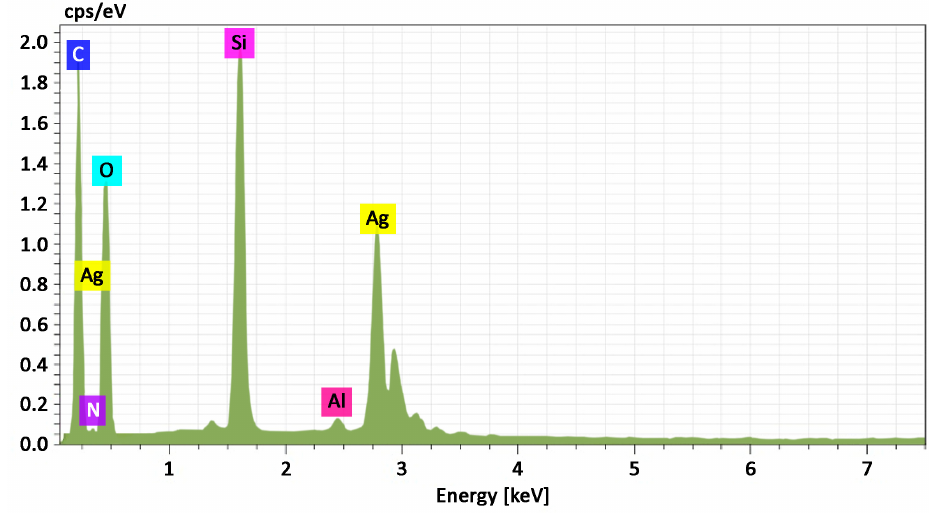
Figure 6. Energy ‐ dispersive X ‐ ray spectrum from Ag NPs/HBPAPES/cotton, mass. %. C 47.98; N 3.67; O 37.05; Si 7.72; Ag 3.42. SEM showed that the metal nanoparticles have a wide size distribution after 2 ‐ propanol removal. The metal particles are aggregated into bunch ‐ like objects in which smaller metal nanoparticles are combined (Figure 7).